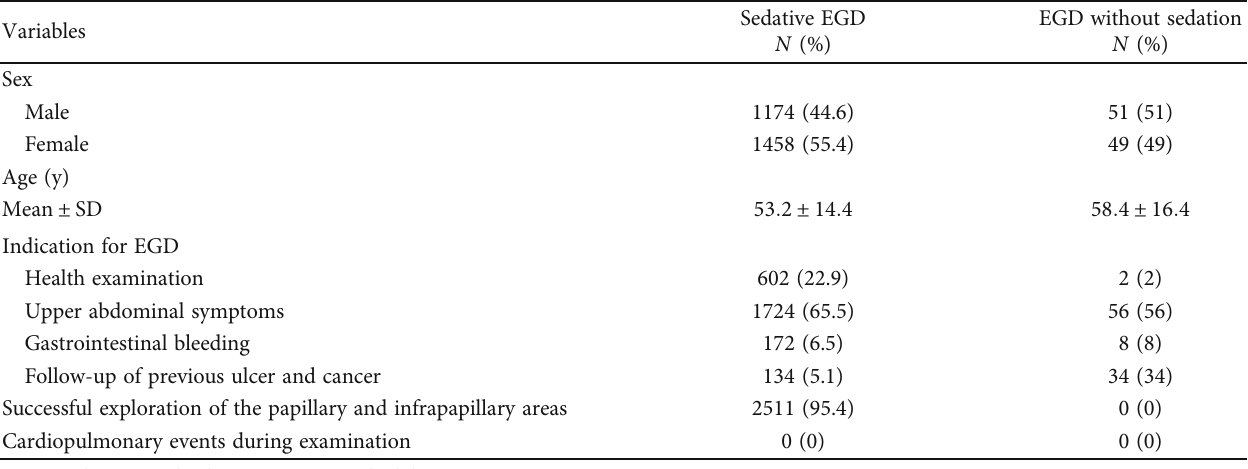
Table 1: Demographic and clinical characteristics between patients receiving EGD with and without sedation.